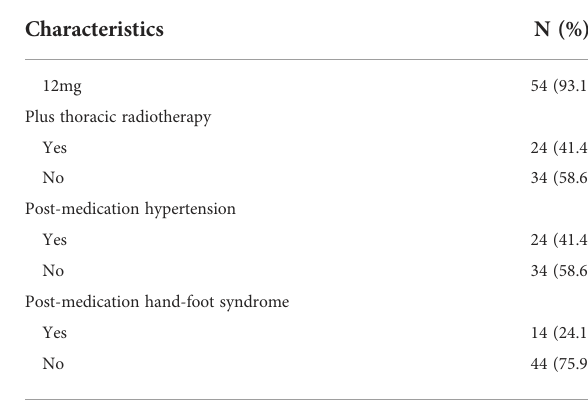
TABLE 1 Baseline clinical characteristics of